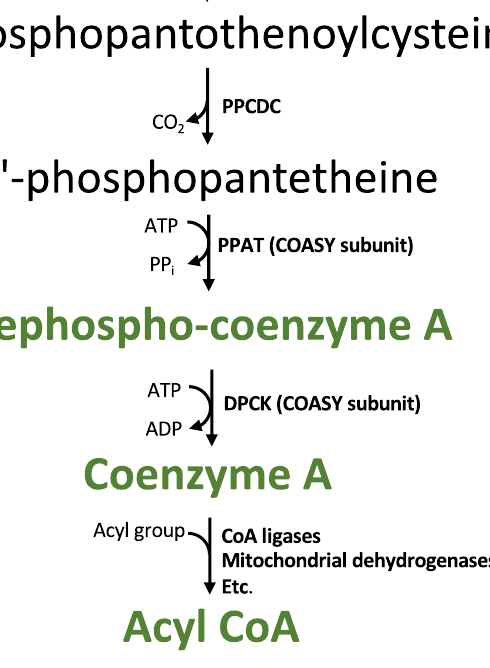
Figure 1. The CoA biosynthetic pathway: the metabolites detected by the method detailed in this manuscript are highlighted in green. Abbreviations: PANK = pantothenate kinase; PPCS = phosphopantothenoylcysteine synthase; PPCDC = phosphopantothenoylcysteine decarboxylase; PPAT = phosphopantetheine adenylyl transferase; and DPCK = dephosphocoenzyme A kinase. The bifunctional enzyme Coenzyme A synthase (COASY) is comprised of PPAT and DPCK.